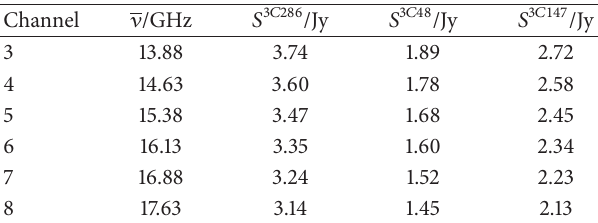
Table 2: Assumed 𝐼 + 𝑄 flux densities of 3 𝐶 286, 3 𝐶 48, and 3 𝐶 147.